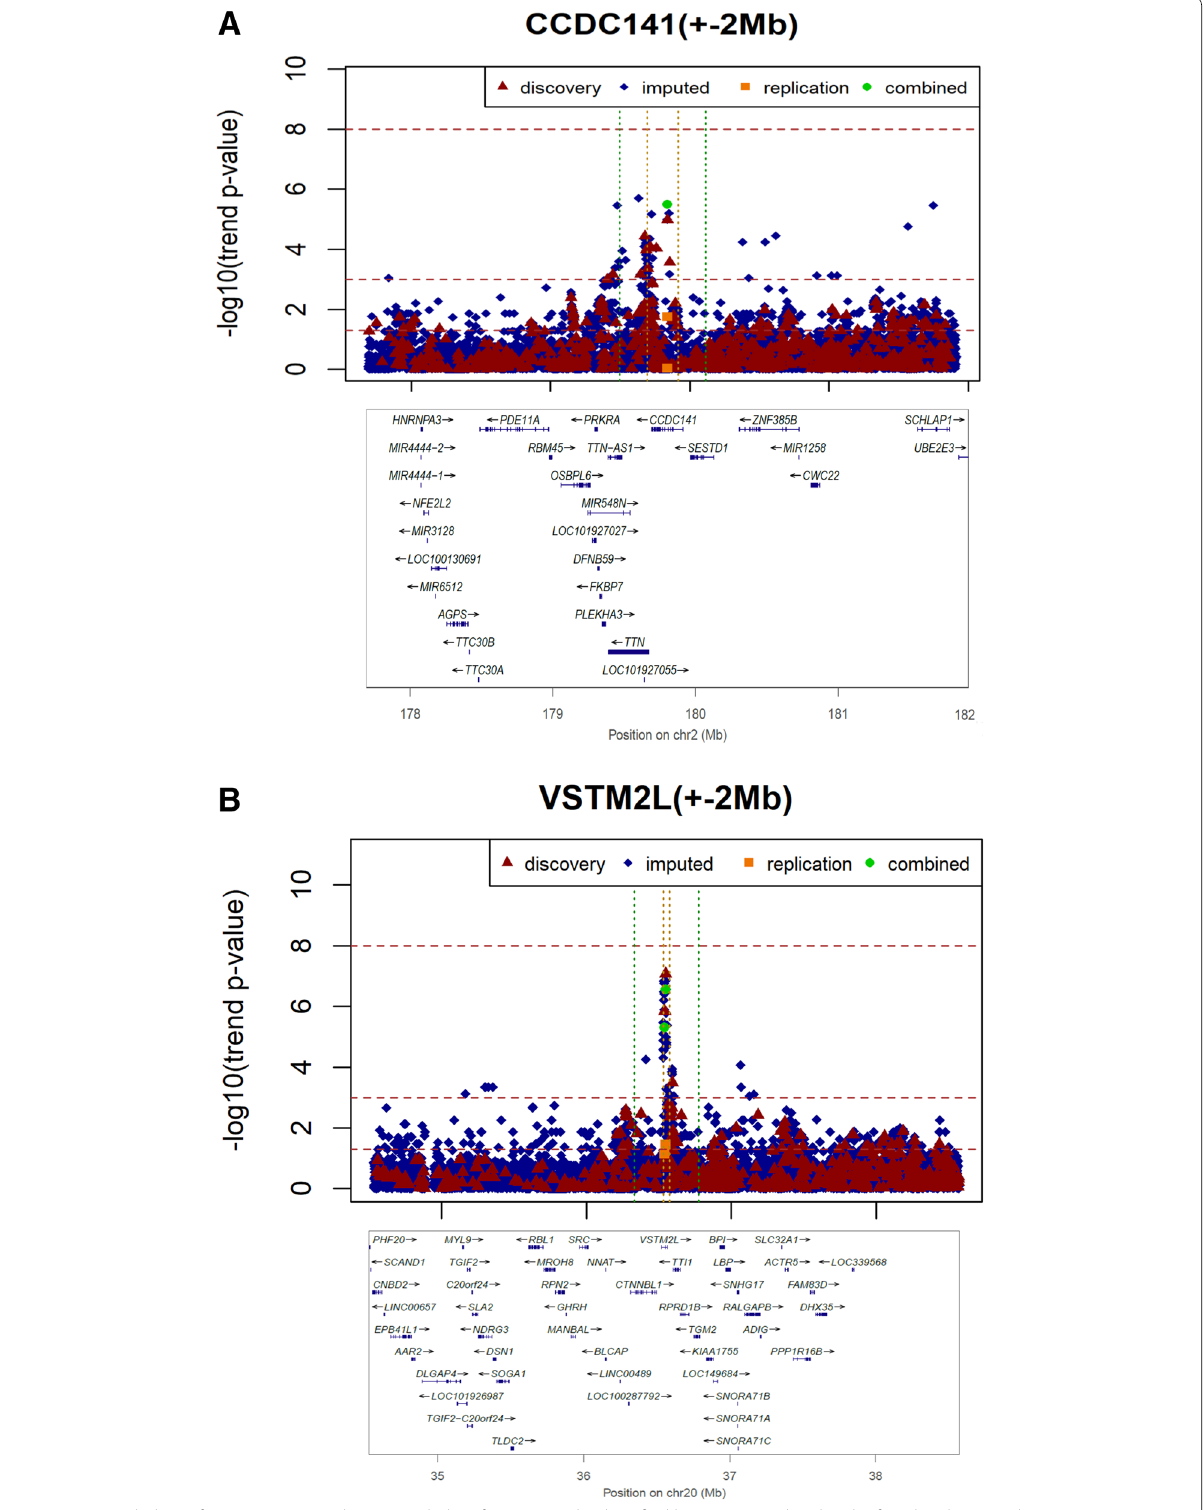
Fig. 2 Regional plots of association signals. Regional plots for two newly identified loci associated with risk of restless legs syndrome in patients with migraine. Each regional plot shows the chromosomal position (GRCh37/hg19) of SNPs in the specific region against –log 10 P values from association results of genotyped and imputed SNPs in stage 1 GWAS samples and stage 2 replication